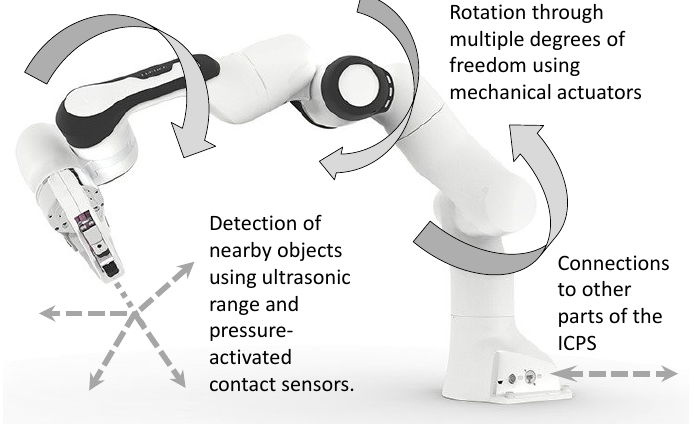
Figure 1. A Franka Emika Panda Collaborative Robot operating as part of an